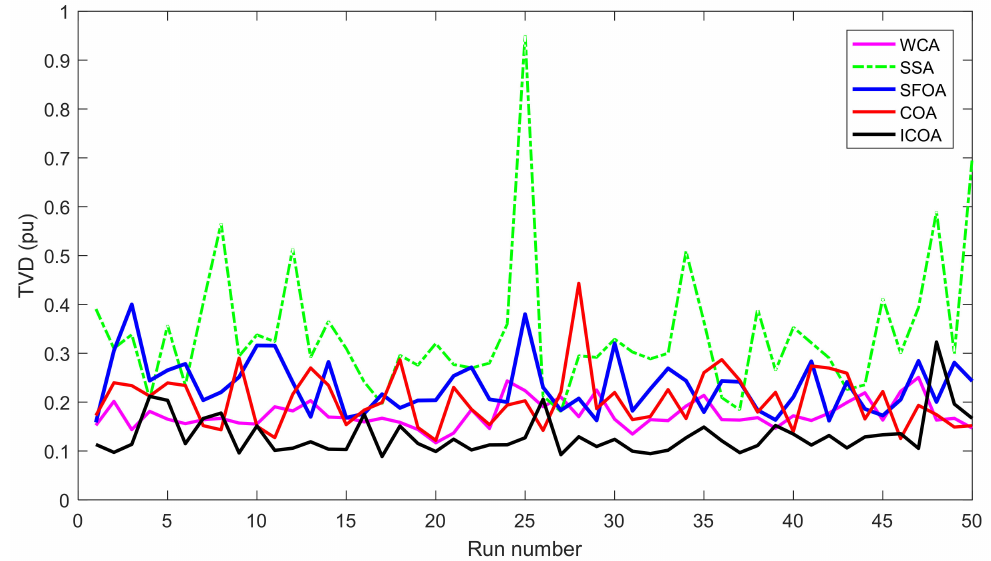
Figure 6. TVD of 50 runs obtained by compared methods for the IEEE 30-bus